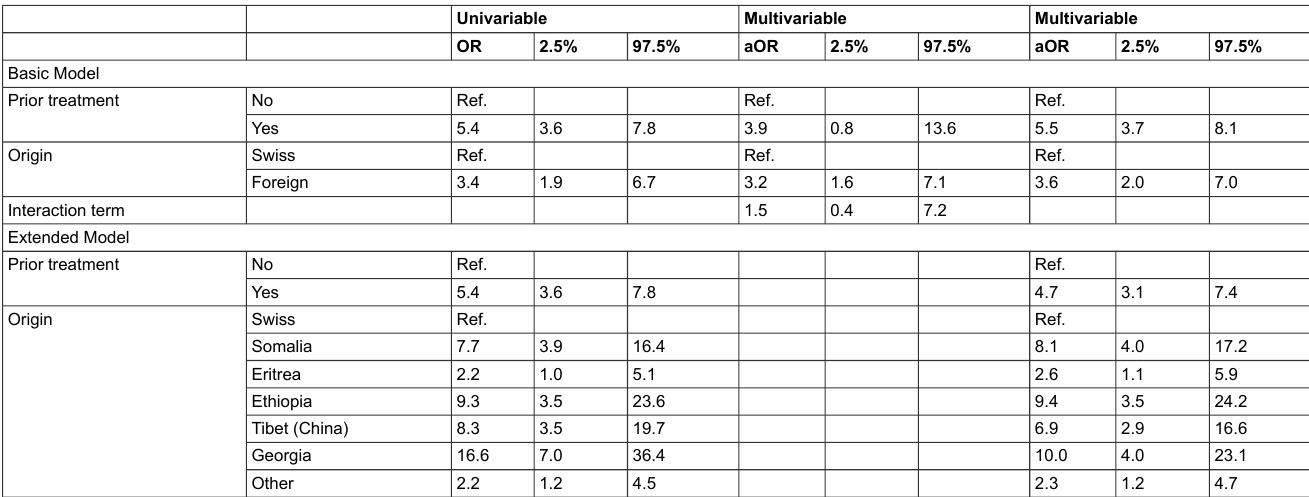
Tabler 3: Rifampicin resistance risk factor models, Switzerland and Liechtenstein, 2009–2019.